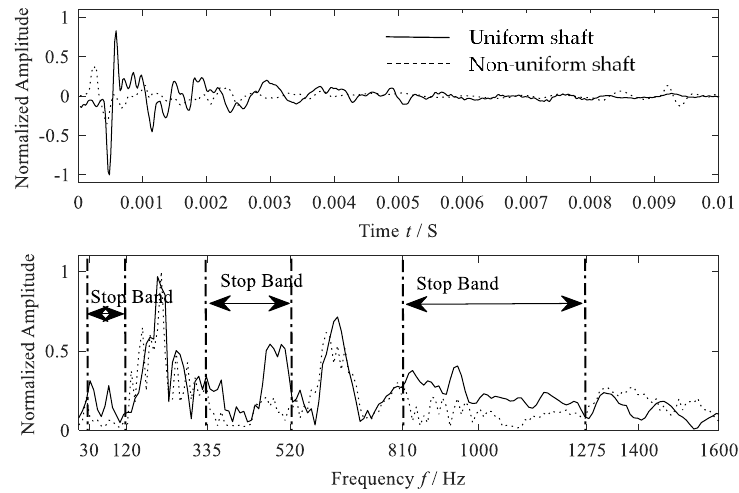
Figure 7. Experimental Stop Bands derived by spectrum comparison.